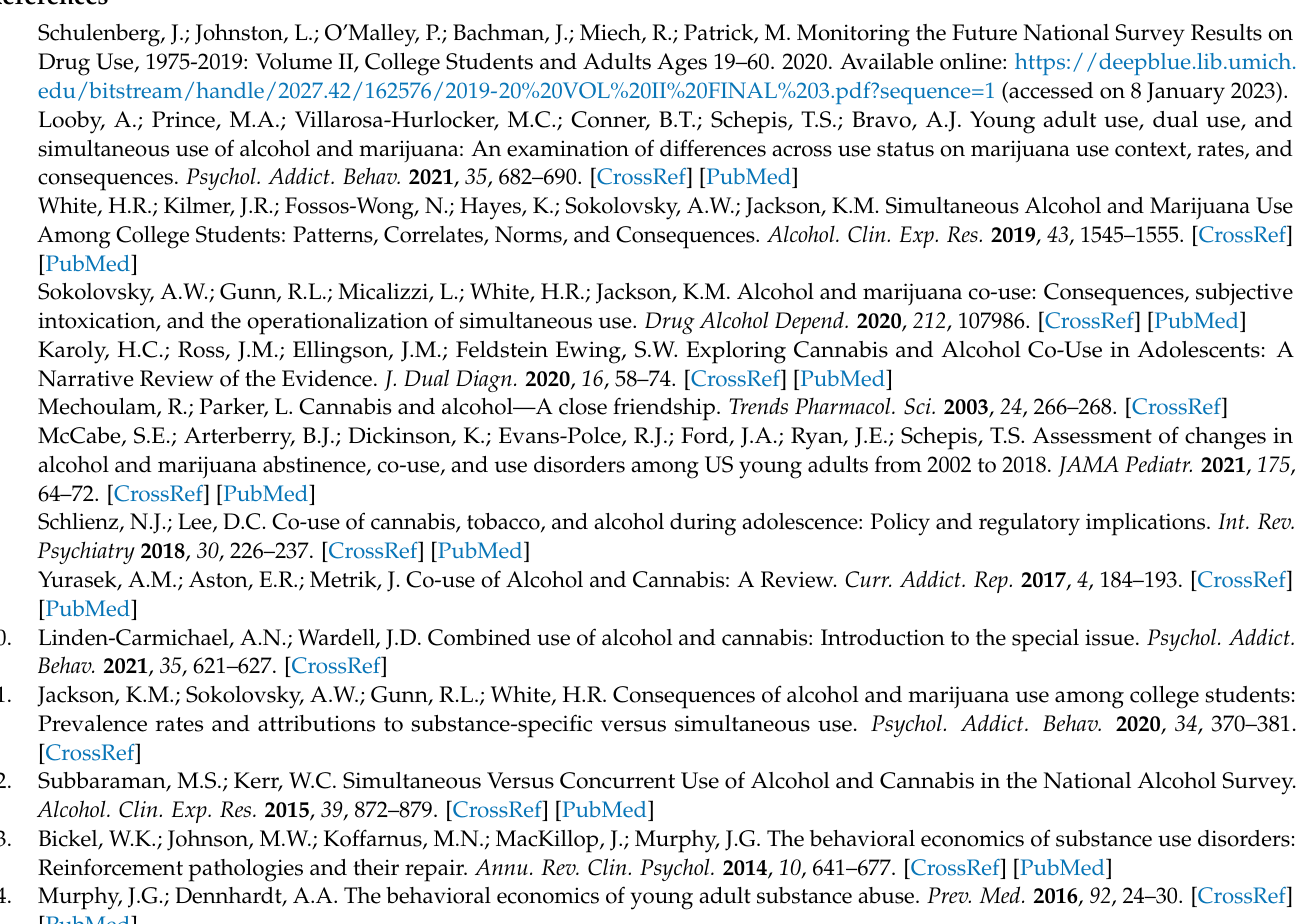
Table S2: Association between Types of Alcohol-Free Reinforcement and Days of Co-use of Alcohol and